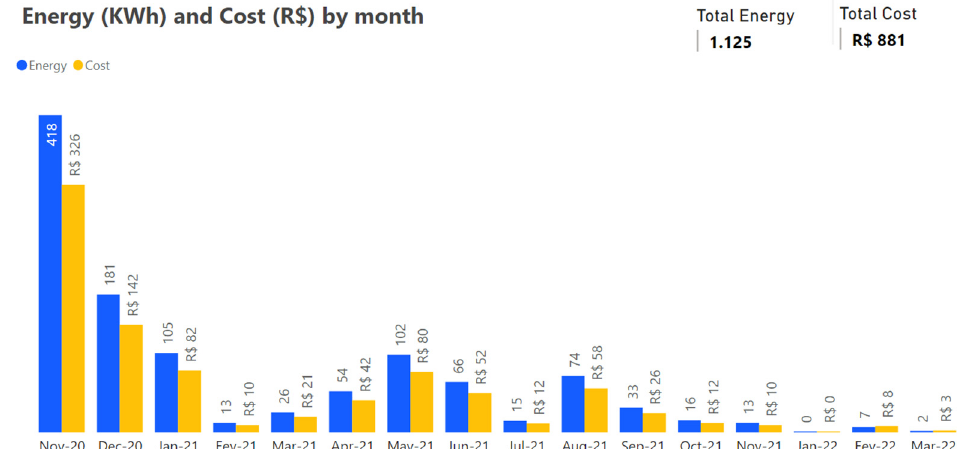
Figure 1. Energy consumption and costs of Operation 1 (ultra-light vehicles).